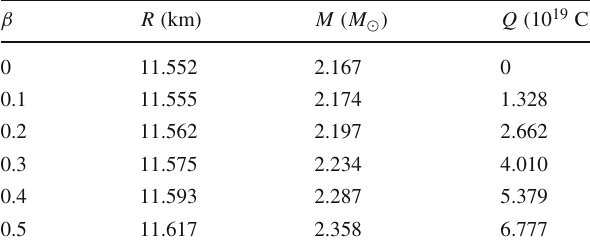
Fig. 2 Mass parameter (left panel) and electric charge (right panel) as functions of the radial coordinate. The results are for the same solution as in Fig. 1. It can be observed that the electric charge increases both the radius and the mass (on the surface) as β becomes more positive